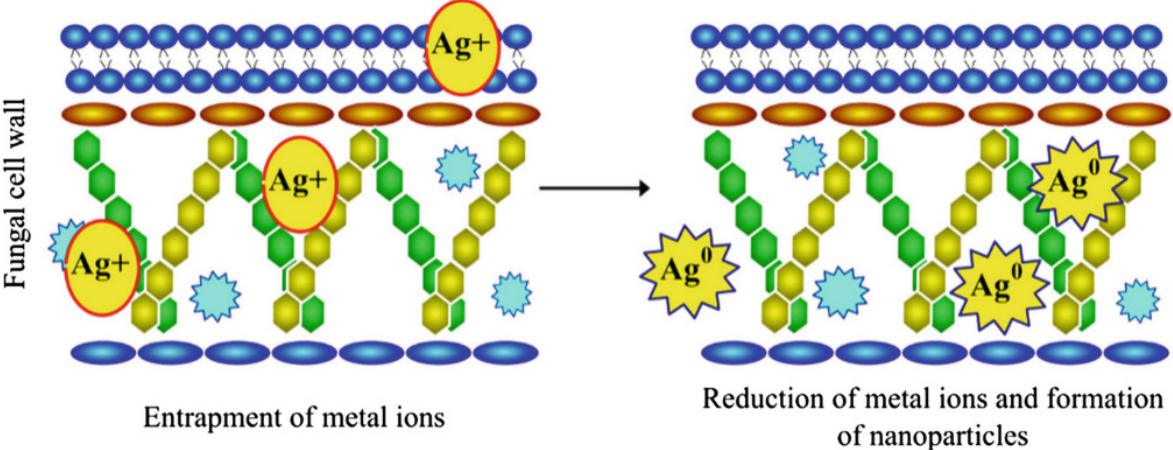
Figure 6. Possible hypothetical mechanism for intracellular mycosynthesis of AgNPs, reproduced with permission from Yadav et al. [40].